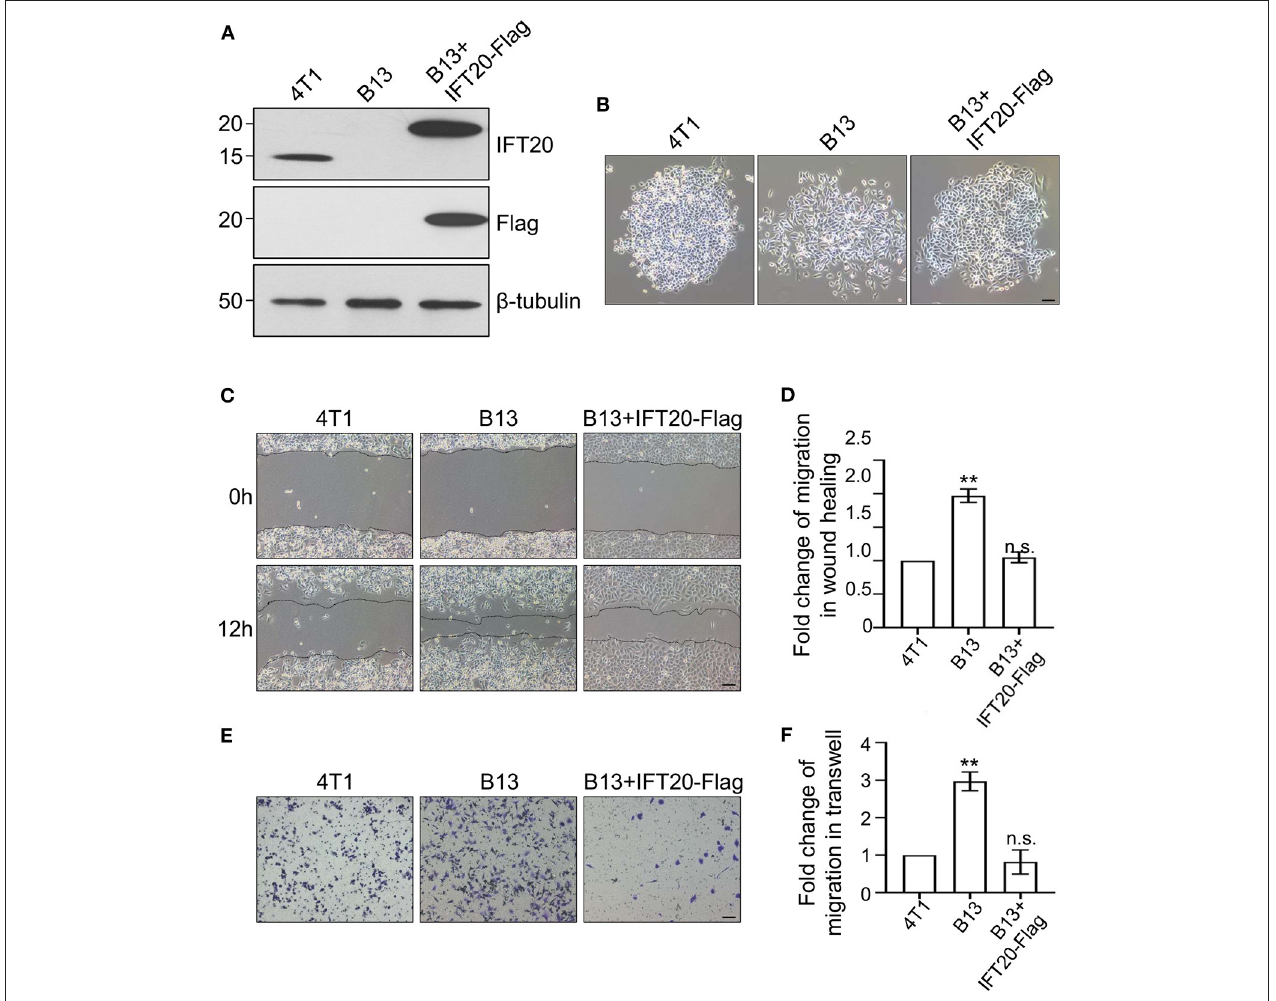
FIGURE 3 | Loss of IFT20 enhances the migration of breast cancer cells. (A) Western blots of lysates from 4T1, B13 (IFT20-KO), and B13 + IFT20-Flag cells (B13 cells stably expressing IFT20-Flag) probed with IFT20 antibodies. β -tubulin was used as the loading control. (B) Phase-contrast images of 4T1, B13, and B13 + IFT20-Flag cells. (C) Representative pictures of cell migration in 4T1, B13, and B13 + IFT20-Flag cells as evaluated by the wound healing assay. (D) Quantification of the wound healing distance in (C) after 12h showed that the loss of IFT20 enhanced horizontal migration. n = 24 fields of view in three independent experiments. (E) Representative pictures of cell migration in 4T1, B13, and B13 + IFT20-Flag cells as evaluated by the transwell assay. (F) Quantification of migrated cell numbers in (E) showed that the loss of IFT20 significantly enhanced cell migration. n = 18 fields of view in three independent experiments. Represented data are the mean ± SD in three biological replicates. n.s. (not significant) p > 0.05; * p ≤ 0.05; ** p ≤ 0.01. Scale bar, 50 µ